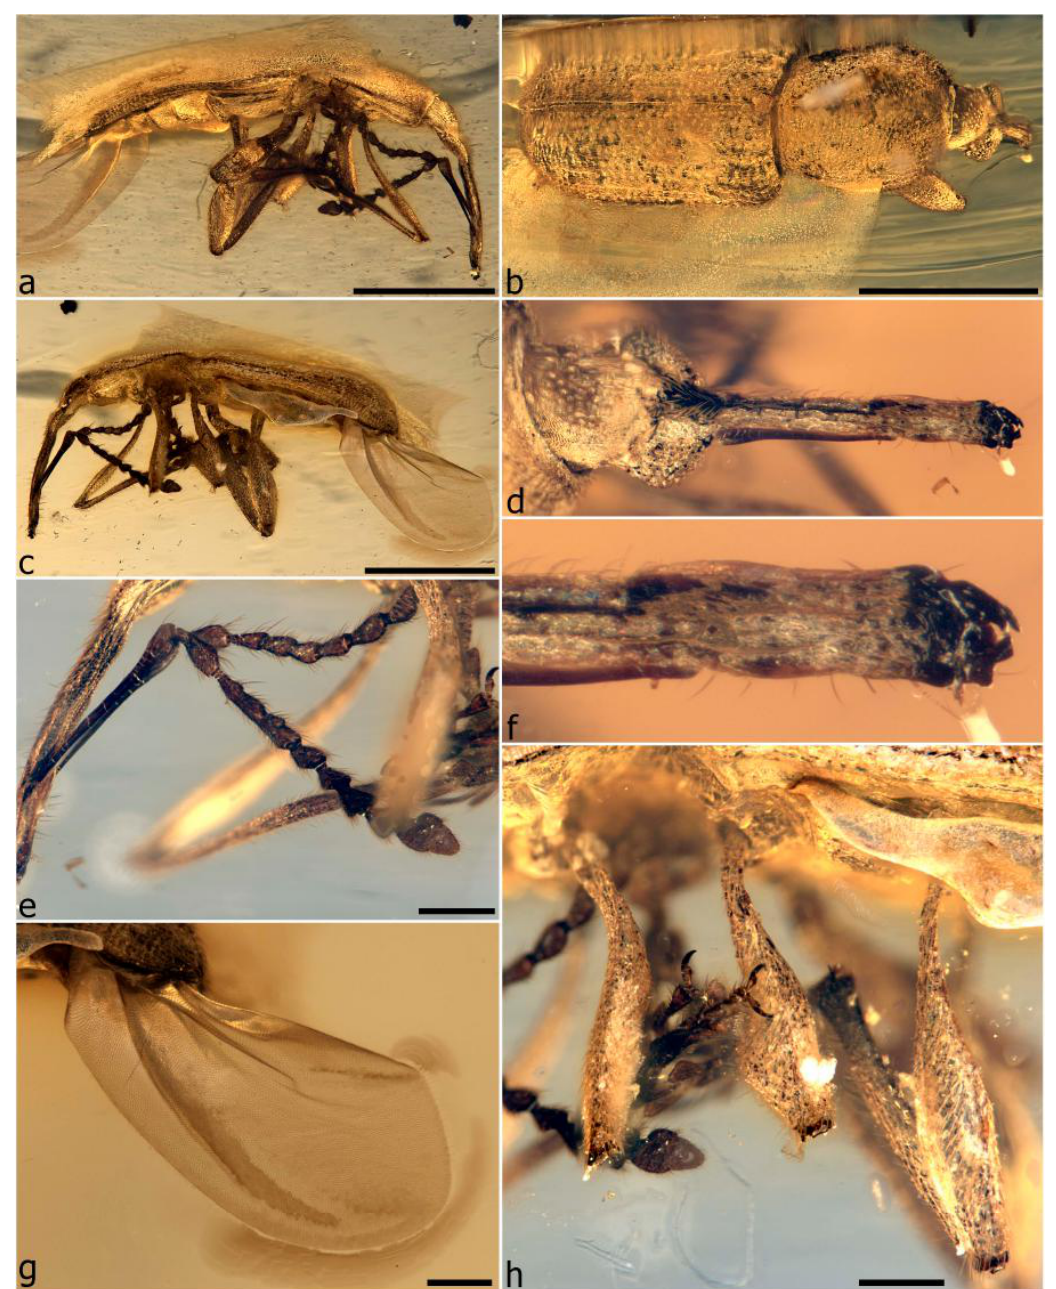
Figure 74. Periosocerus deplanatus sp. n., holotype. Habitus, right lateral ( a ); habitus, dorsal ( b ); habitus, left lateral ( c ); head, dorsal ( d ); left antenna ( e ); apical part of rostrum and mandibles ( f ); distal part of hindwing ( g ); left femora and tarsal claws ( h ). Scale bars: 1.0 mm (a–c); 0.2 mm (e,g,h).